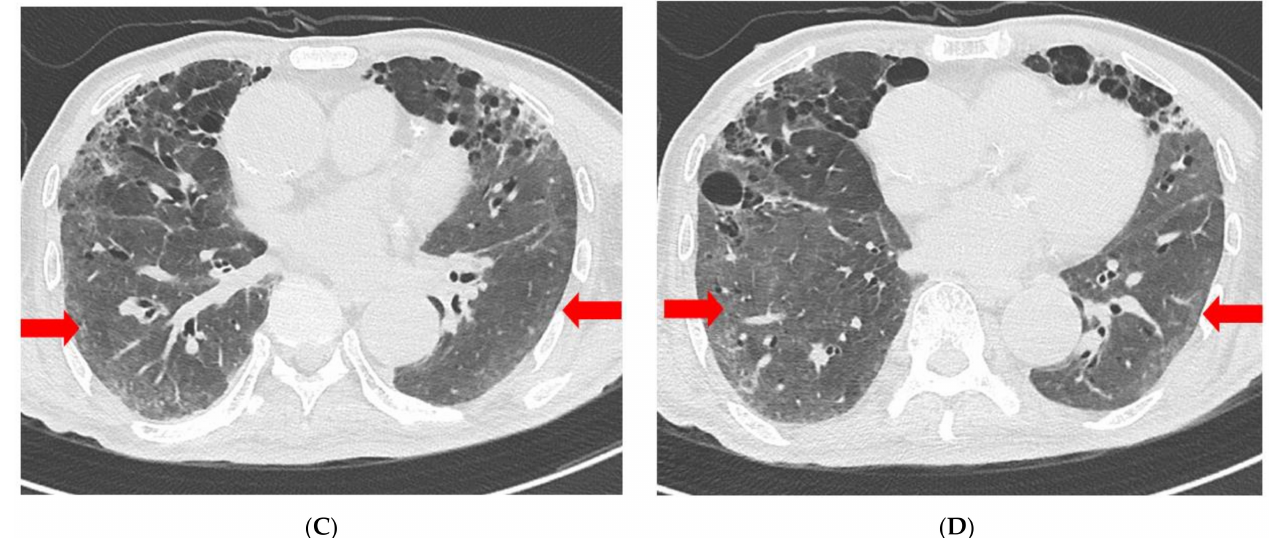
Figure 4. Chest CT scan obtained on Day 106 of MSC transplantation reveals absence of cavity ( A ) and pulmonary consolidation ( B ) at right upper lobe presented in the previous CT scan, and decreased GGO at both lungs ( C , D ) compared with previous CT scan. Each finding is indicated with red arrowheads. CT, computed tomography; GGO, ground-glass opacity; MSC, Mesenchymal stem